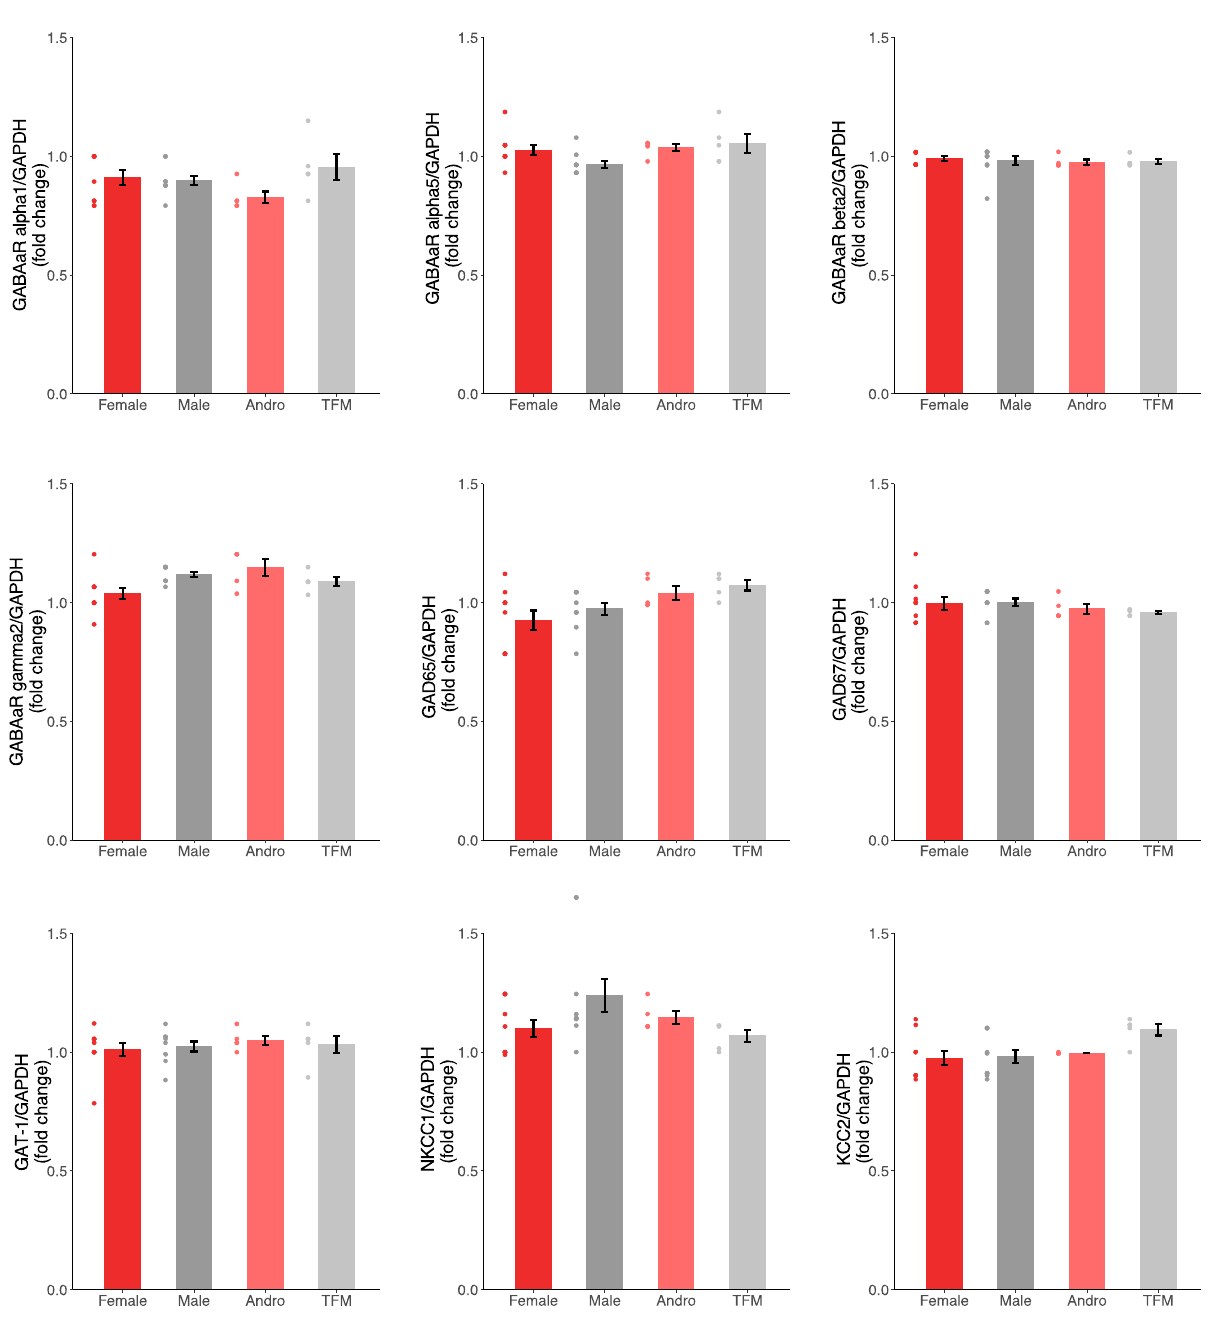
Figure 3. Testosterone does not affect mRNA levels of major GABAergic neurotransmission determinants. ( A , B ) Fold-change values in mRNA expression of GABA signaling components extracted from rat hippocampus at P7 ( A ) and P40 ( B ) do not show significant differences between groups (F: n = 10 rats from 3 litters; M: n = 10 rats from 3 litters; A: n = 5 rats from 3 litters; TFM: n = 5 rats from 3 litters; One-way ANOVA with Tukey’s post hoc analysis, p > 0.05, fold change > 2 or < 0.5 for all comparisons at P7; One-way ANOVA with Tukey’s post hoc analysis, p > 0.05, fold change > 2 or < 0.5 for all comparisons at P40). Dots represent individual data points. F females, M males, A andro/testosterone-treated females, TFM testosterone-insensitive males. Graphs represent mean ±